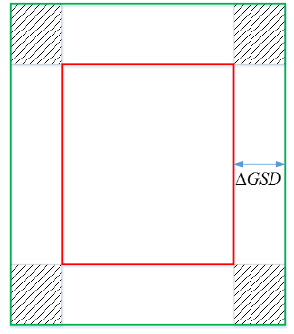
Figure 4. Area difference estimation between the LiDAR-derived contour and the actual